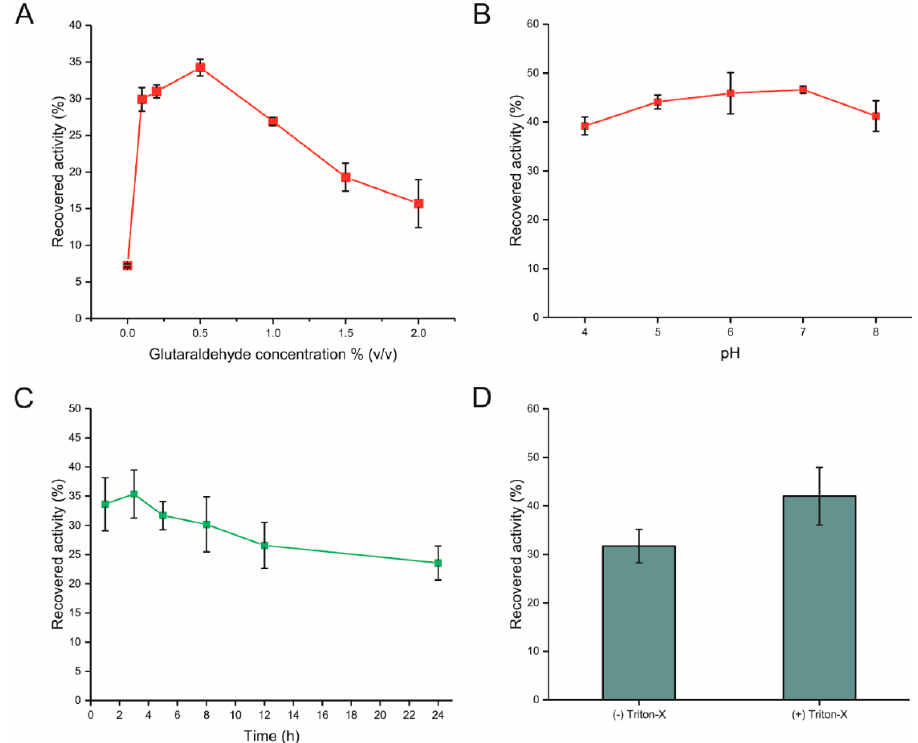
Figure 2. Effect of ( A ) glutaraldehyde concentration, ( B ) pH, ( C ) incubation time, and ( D ) Triton-X100 treatment on the recovered activity of CLEAs. The data represent means of three assays and the error bars represent the standard deviation.